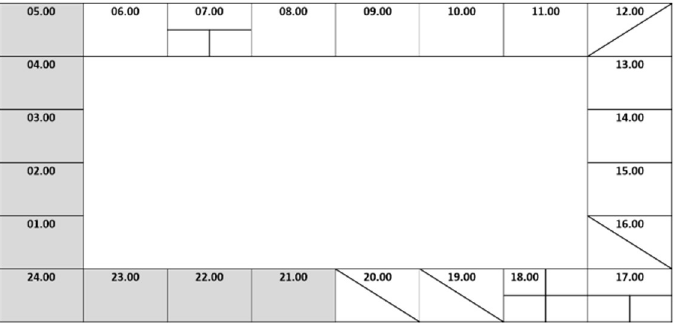
Figure 1. 24 h activity log.